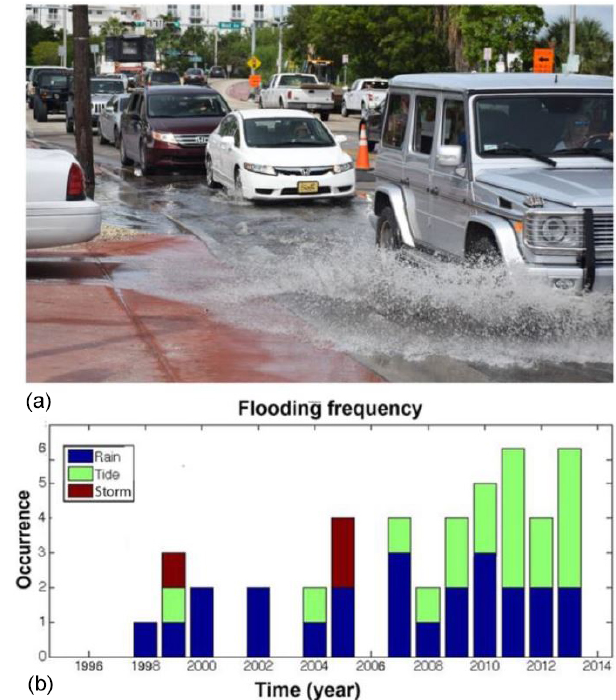
Figure 1. (a) “Sunny sky” flooding in Miami Beach. (b) Annual flooding occurrence in Miami Beach between 1998–2013 indicat- ing a significant increase in tide flooding events (green) since 2006 (modified after Wdowinski et al.,